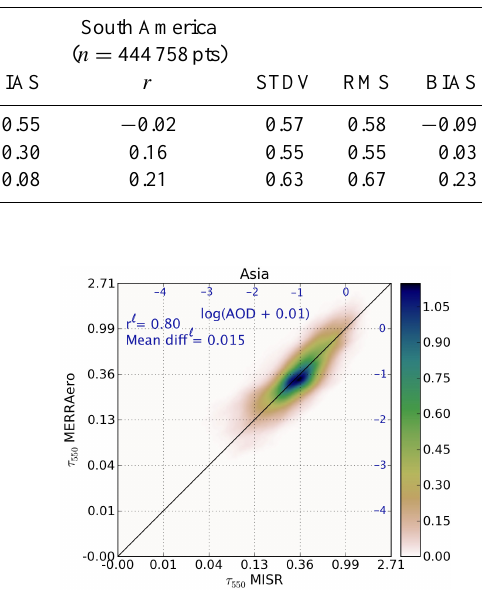
Figure 14. Same as Fig. 9 but for the Asian region during AMJ 2007. Table 5. Same as Table 1 for the Asian